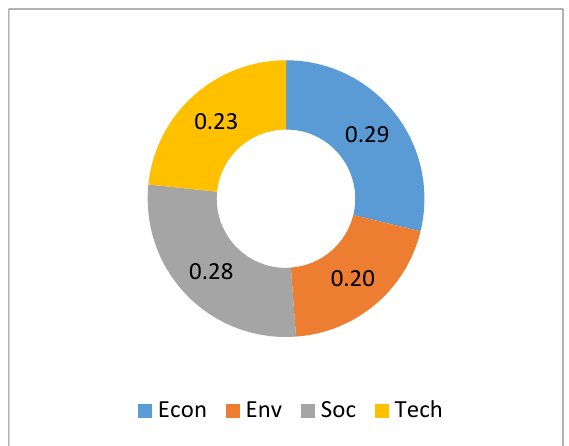
Figure 9. Weights of the sustainability dimensions according to the analysis of the preferences of the stakeholders.